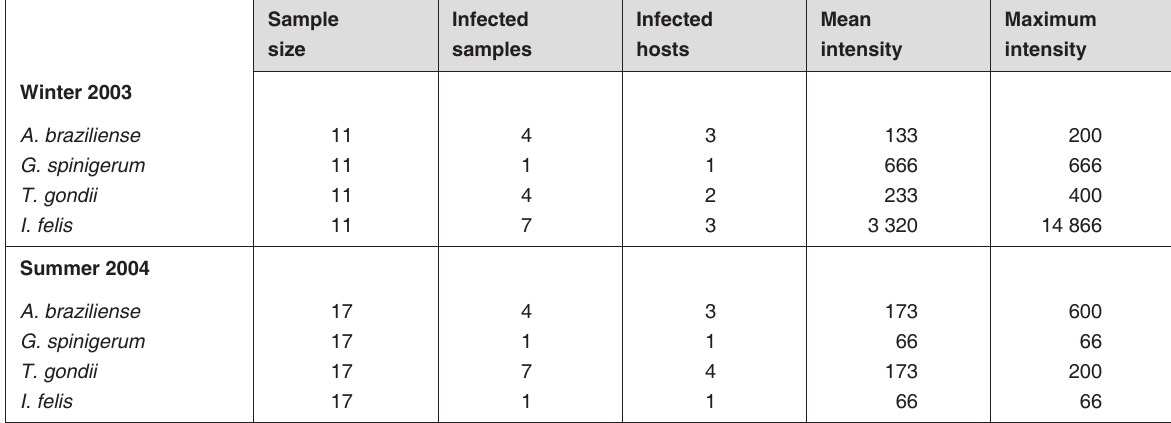
TABLE 2 Egg and oocyst counts of endoparasites in the pride of African lions at Intu Afrika Kalahari Game